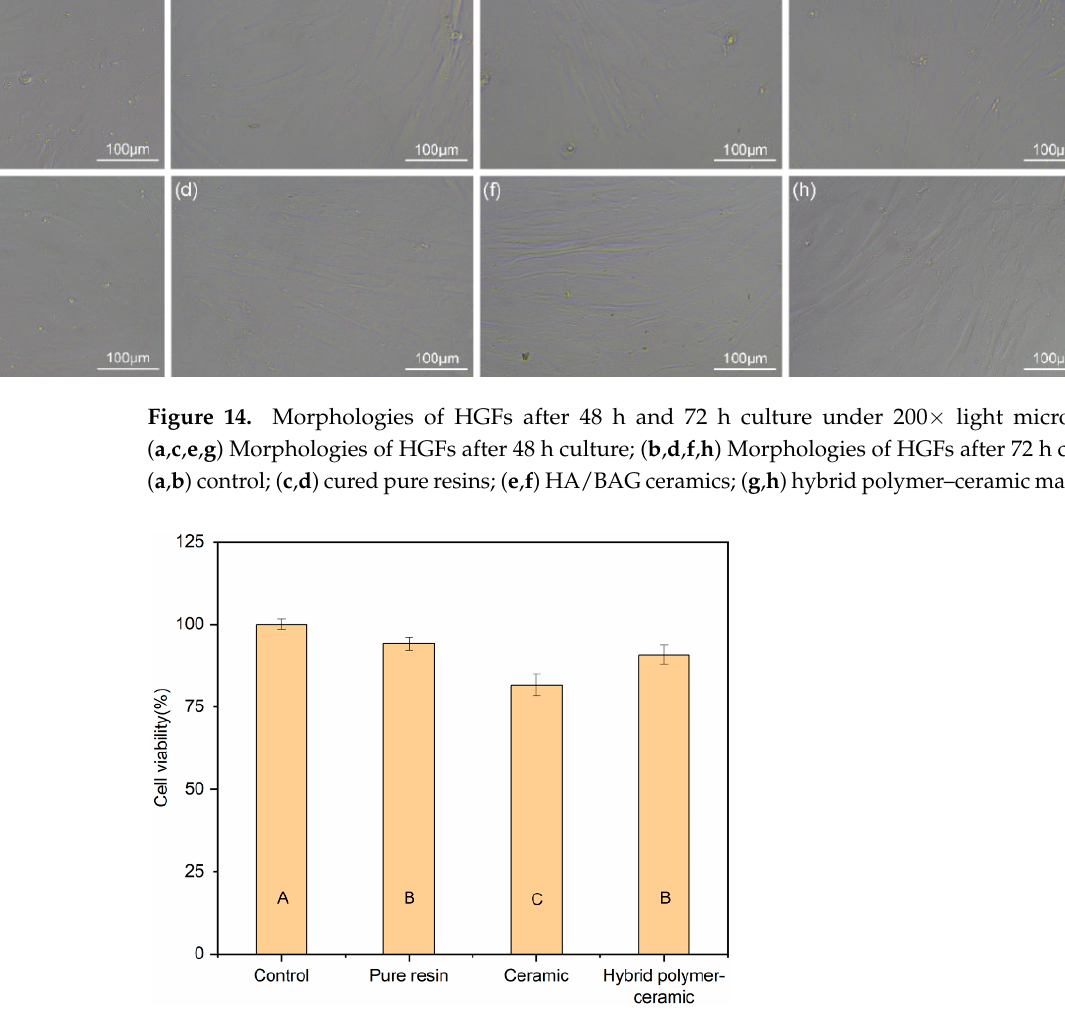
Figure 15. Cell viability of HGFs cultured on different materials for 72 h. A the same uppercase letters indicate that there was no significant difference between different materials ( p = 0.05). The data were significantly drawn from a normally distributed population at the 0.05